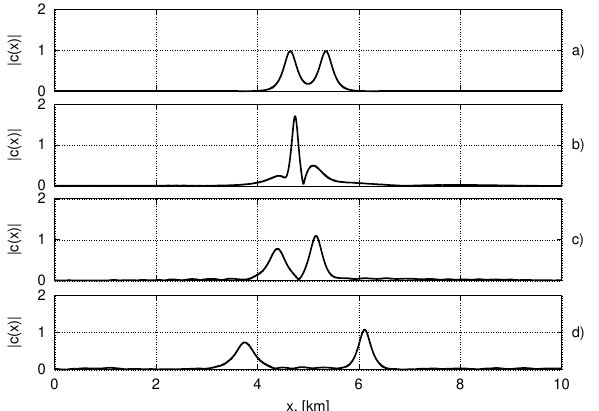
Figure 4. The process of splitting the NLSE bi-soliton in two separate solitons for the case of µ ini = 0.2 and κ = 1.1: the initial state of bi-soliton ( a ), the interaction of bi-soliton ( b ), start of the splitting process of bound state ( c ), two separate solitons ( d ).